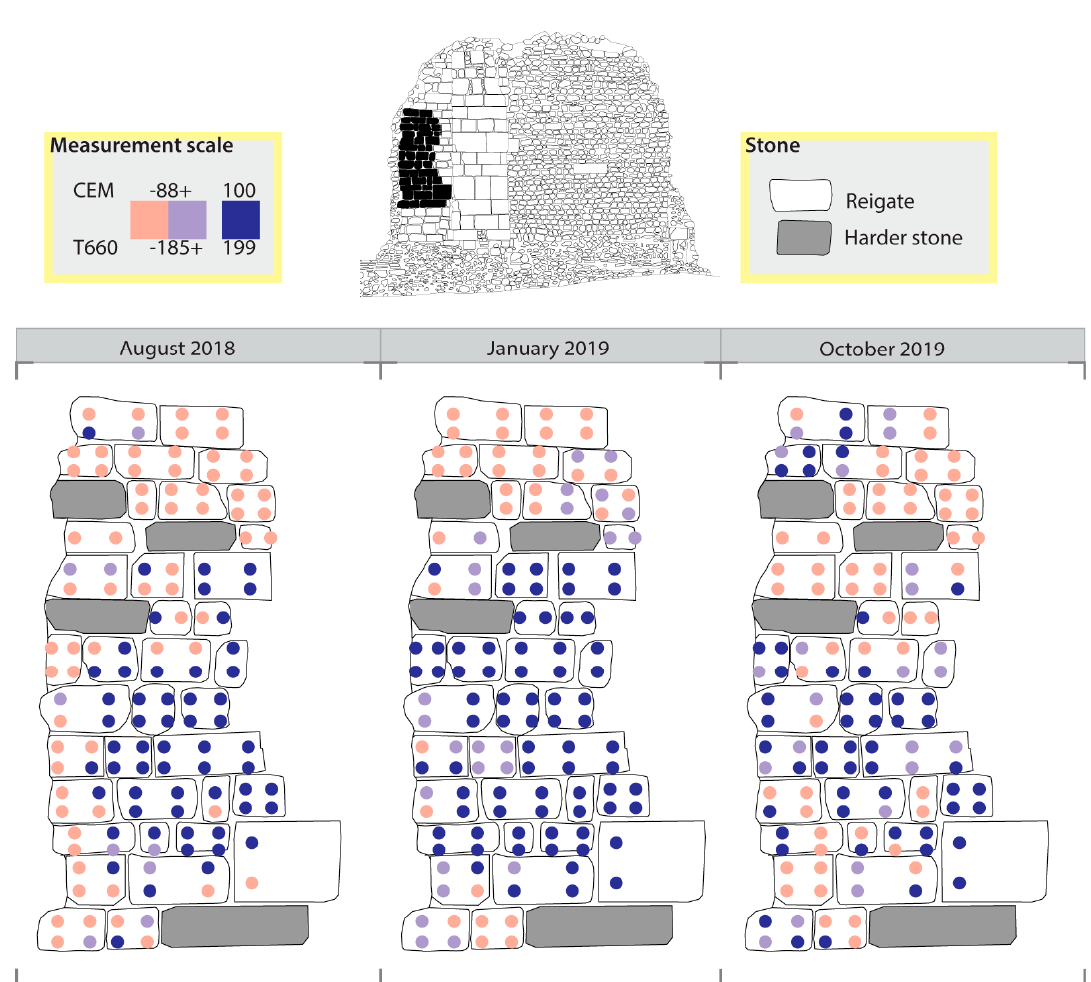
Figure 6. Distribution of moisture meter readings at monument scale across three separate surveys, showing low, high and maximum readings for individual Reigate blocks (one measurement per point). The variation across different seasons highlights the role of macro-scale dynamics, which are likely to outweigh the influence of pointing mortar at individual joints. In particular, the effect of good drying conditions along the edge of the monument (August 2018), and recent rainfall along the top of the monument (October 2019) can be seen.